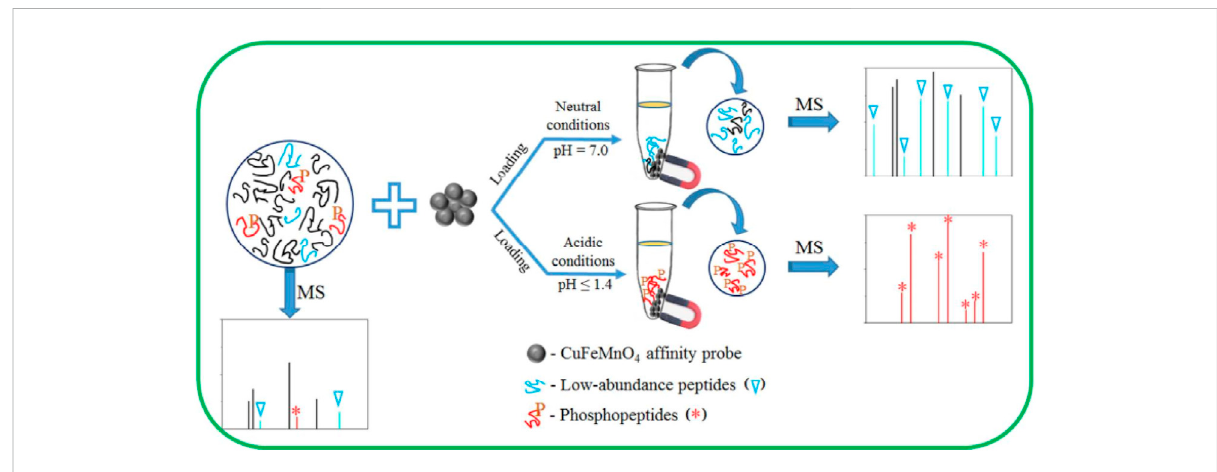
Schematic illustration of strategies employed for enriching phosphopeptides. Reproduced from ref 72. Copyright 2017 American Chemical